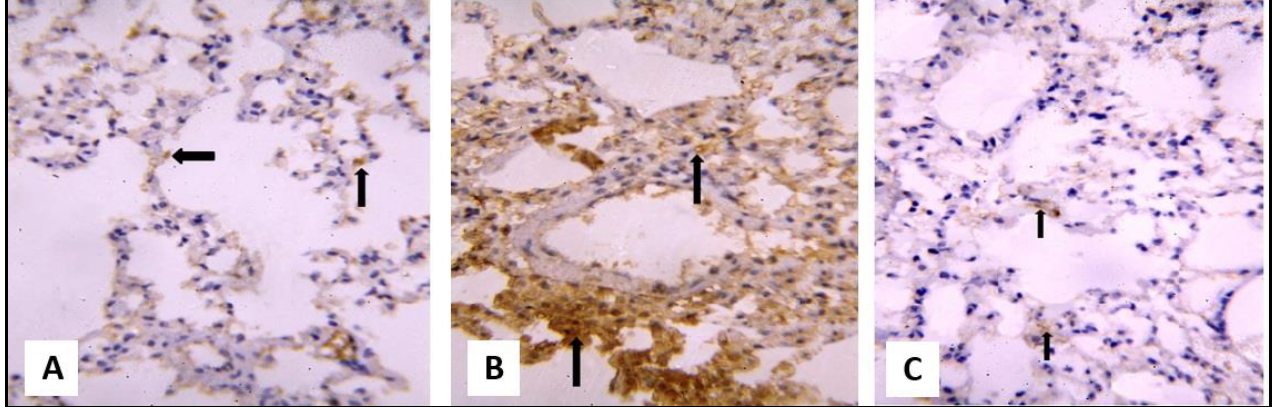
Figure 8. A section of rat lung showing the following features. ( A ) A weakly positive brown cytoplasm reaction along the alveolar epithelial lining of the control group (caspase-3 immunostaining, × 400). ( B ) A dense, positive brown cytoplasmic reaction in the exfoliated cells and interstitial inflammatory cells (black arrow) of group II (caspase-3 immunostaining, × 400). ( C ) A weakly positive brown cytoplasm reaction in the alveolar epithelial lining of group III (caspase-3 immunostaining, × 400).